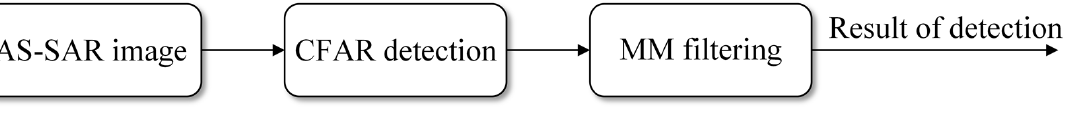
Figure 3. The classical detection flow of SAR images.